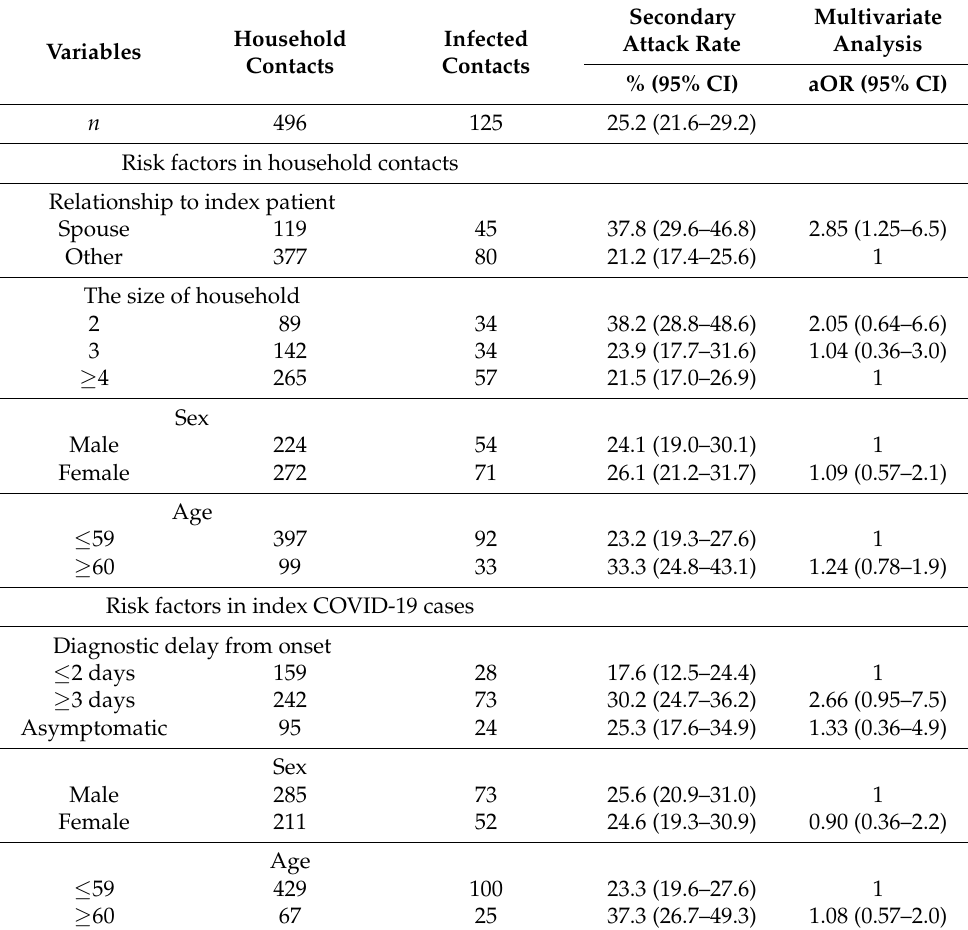
Table 2. Secondary attack rate among household